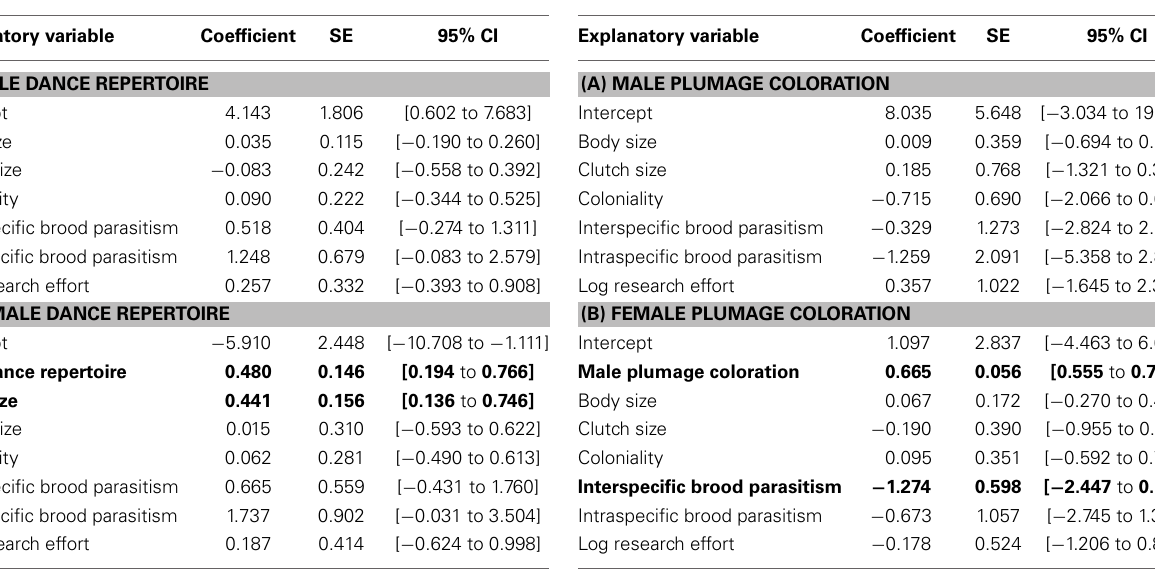
Table 3 | Effects of life-history traits on plumage coloration in male (A) and female (B) Estrildid finches.